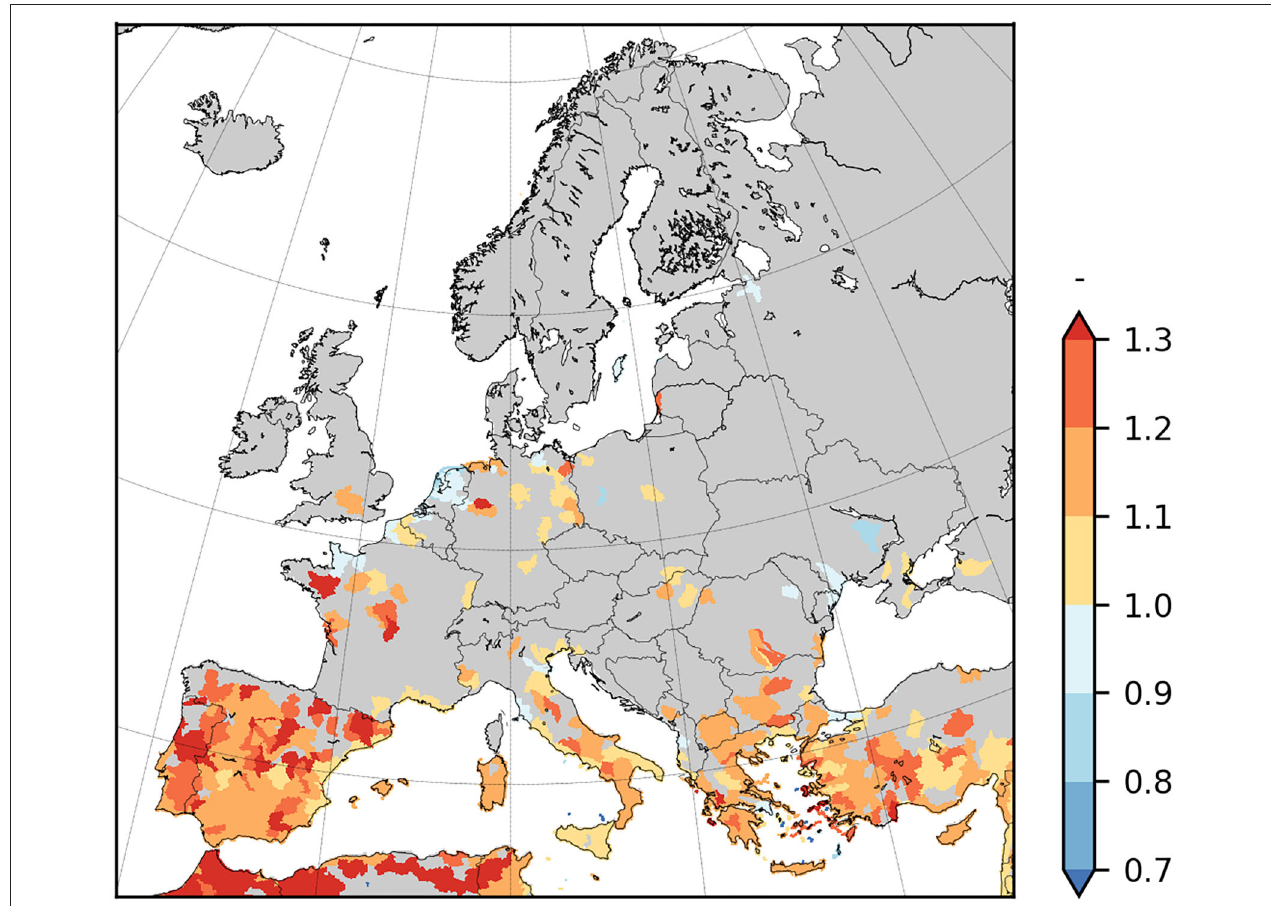
FIGURE 4 | Changes in Water Exploitation Index (WEI + ) due to a 2-degree warmer climate as compared to the 1981–2010 climate (from Bisselink et al., 2020). Ratios are shown here, indicating increases in WEI + due to climate change (ratios larger than 1) or decreases in WEI + (ratios smaller than